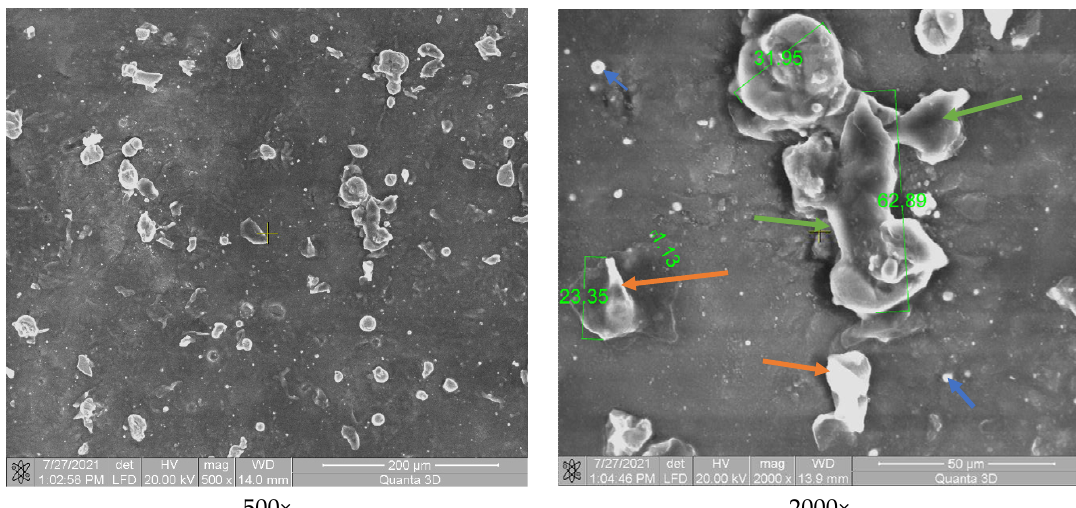
Figure 5. SEM analysis of the P9–136–9 passes samples.